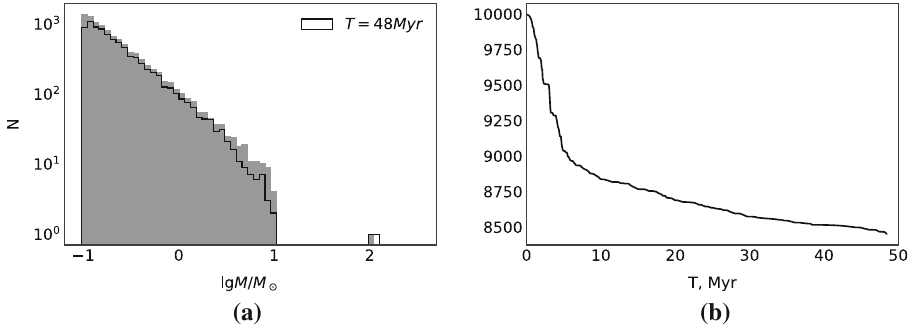
Fig. 7 Dynamics of PBHs cluster with the total mass 3800 M (cid:2) and mass distribution (23) consisting of the N = 10 4 bodies starting from z ∼ 10 4 until the moment z ∼ 40. a Change of the mass spectrum from